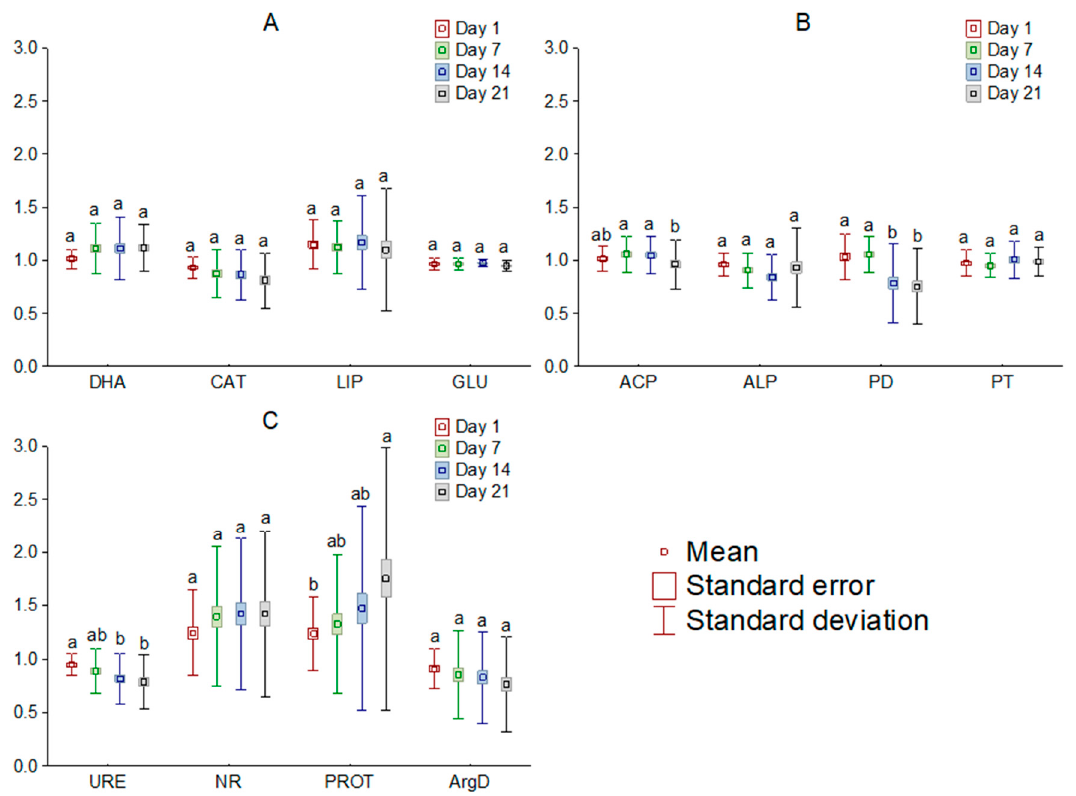
Figure 3. Mean relative activity of the enzymes involved in carbon ( A ), phosphorus ( B ), and nitrogen ( C ) cycle in the soil exposed to tetrabutylphosphonium bromide [TBP][Br] in pot experiment with spring barley, depending on the day of the experiment: values denoted by the same letters for each enzyme do not differ significantly on the level of p = 0.05 (Tukey